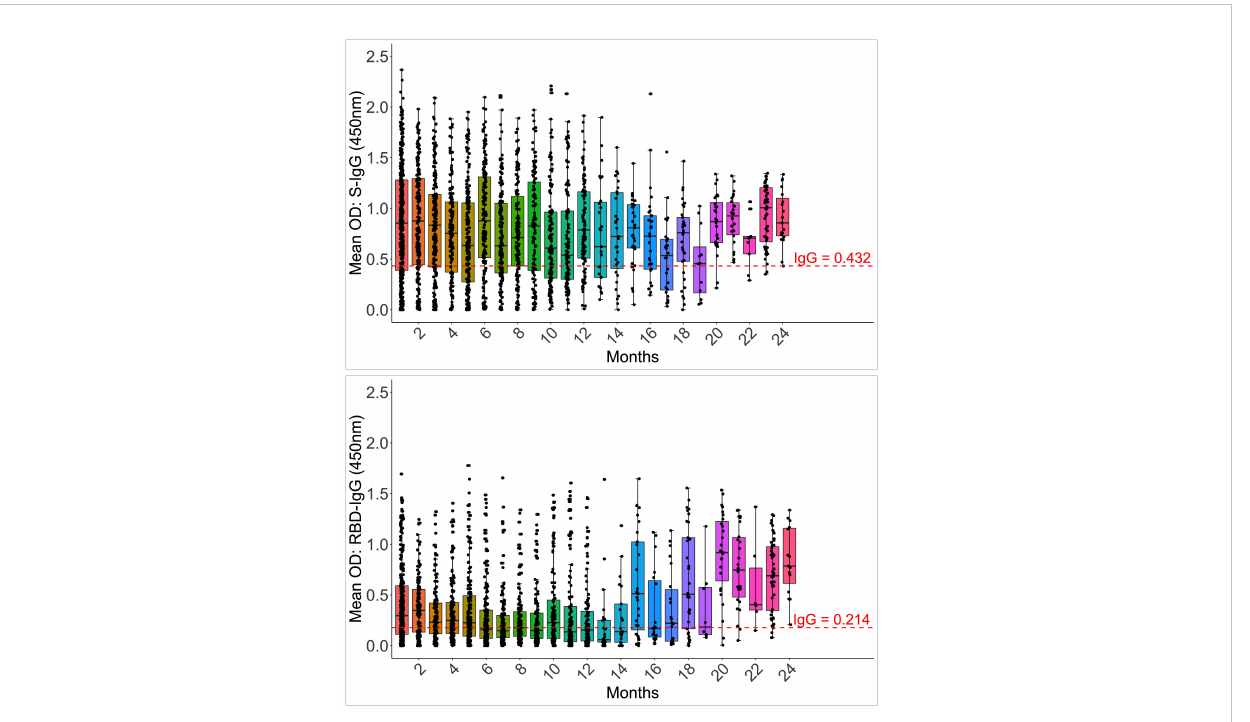
FIGURE 7 Longevity of S-IgG and RBD-IgG antibodies. Figure 7 illustrates the frequency and longevity of S-IgG and RBD-IgG antibodies since initial infection to 24 months, post-infection. Box plots illustrate the median ODs and interquartile ranges over time. Dashed lines indicate cut-off ODs for S-IgG and RBD-IgG